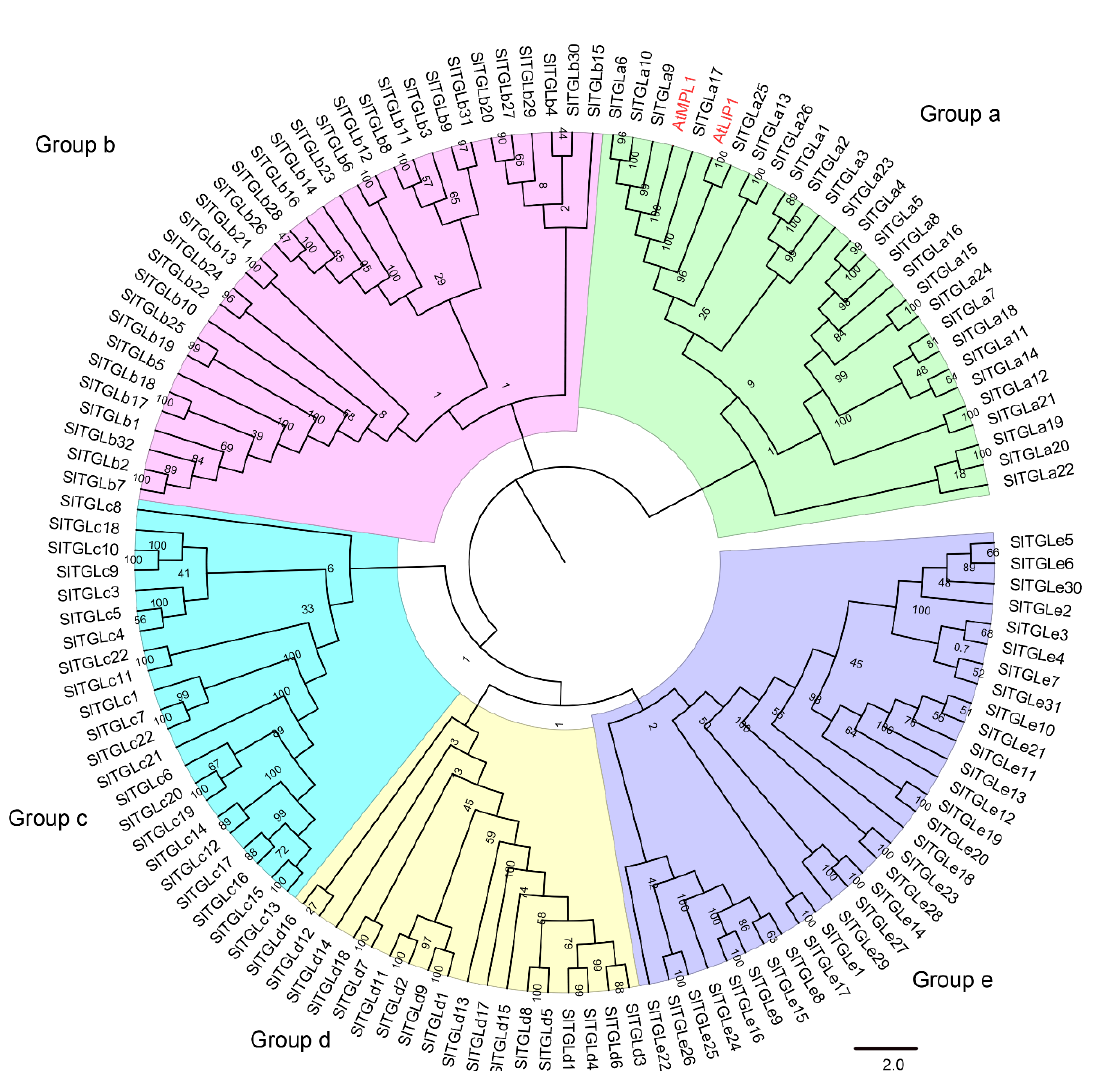
Figure 1. Phylogenetic relationships of SlTGLs from tomato ( S. lycopersicum L.) and AtLIP1 and AtMPL1 from Arabidopsis. Phylogenetic analysis was performed using the neighbor-joining method with 1000 replicates. The TGL proteins were clustered into five groups. The branches of different subfamilies (group a–e) are marked using different colors. Homologous sequences in Arabidopsis are highlighted in red.